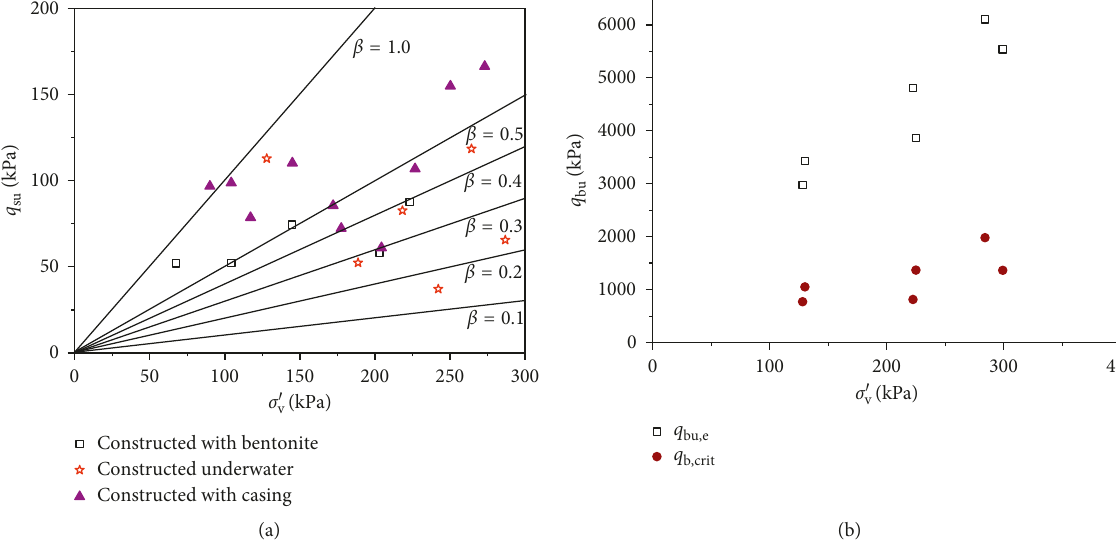
) with the ultimate unit shaft resistance ( q ) su and ultimate unit base v . (b) ( q ) bu versus σ v ′ ′ ′